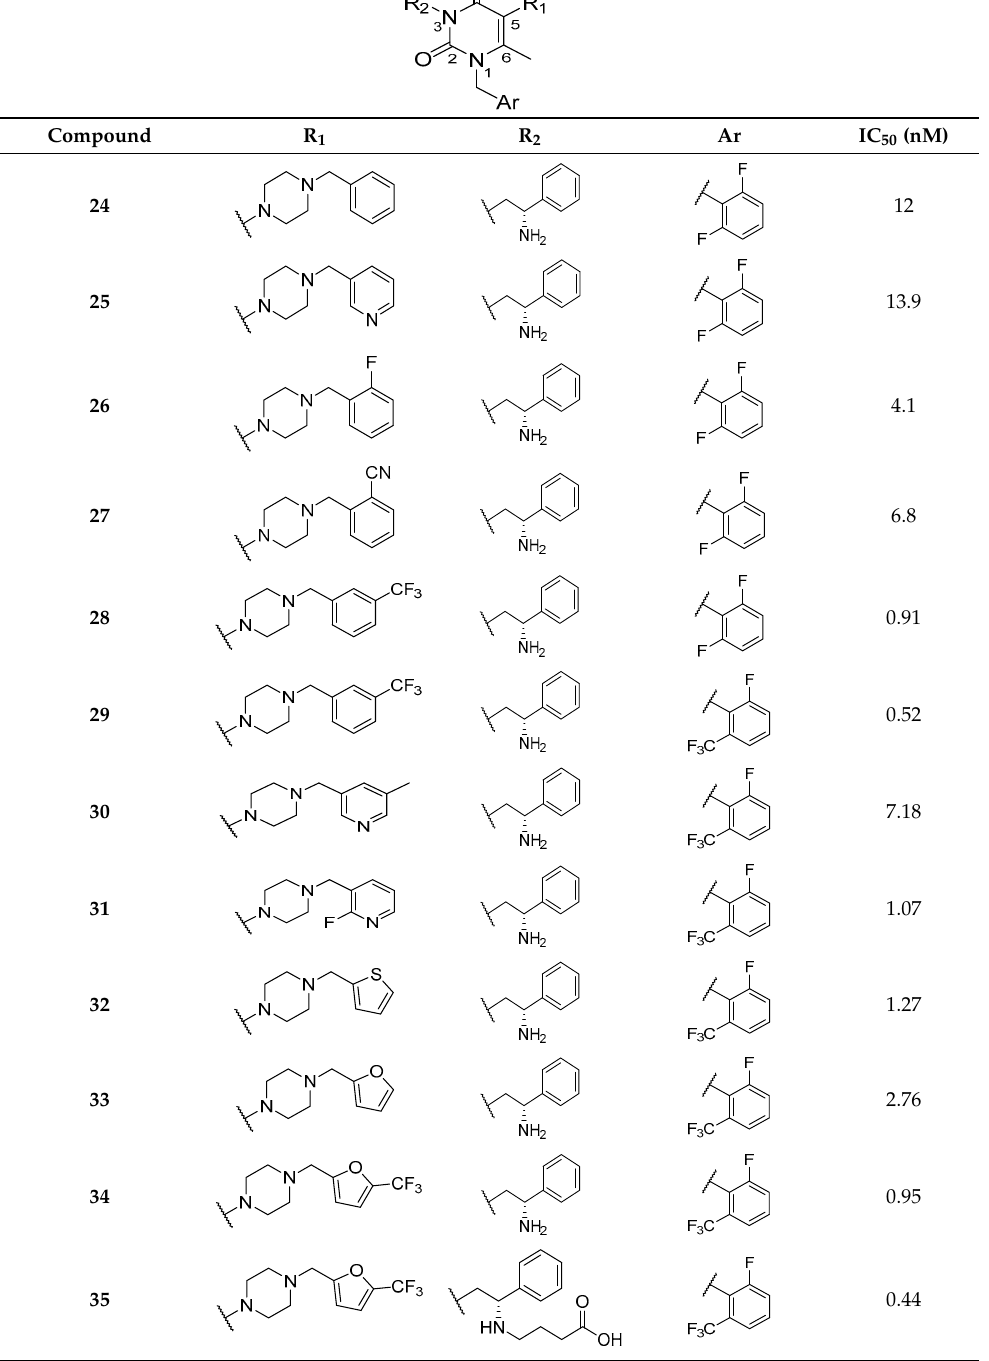
Table 6. Uracil derivatives and their binding affinity at human GnRH-R.